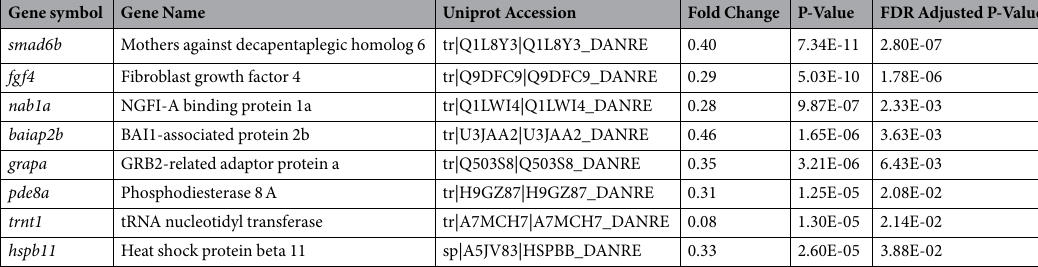
Table 2. List of differentially expressed genes compared to control in Carassius auratus RGC culture after 24 h 1000 nM SNa treatment (FDR <